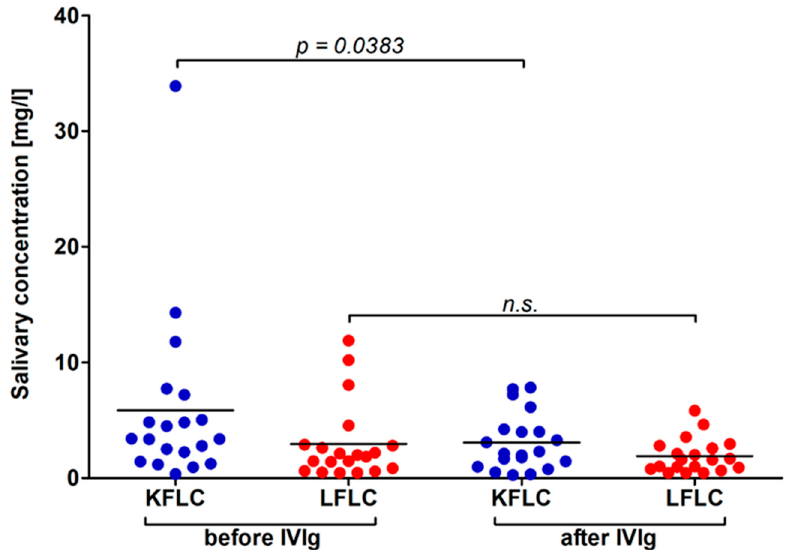
Figure 3. Influence of intravenous immunoglobulins on the salivary free light chain concentrations. KFLC = kappa free light chains; LFLC = lambda free light chains; IVIg = intravenous immunoglobulins; n.s. = not statistically significant.